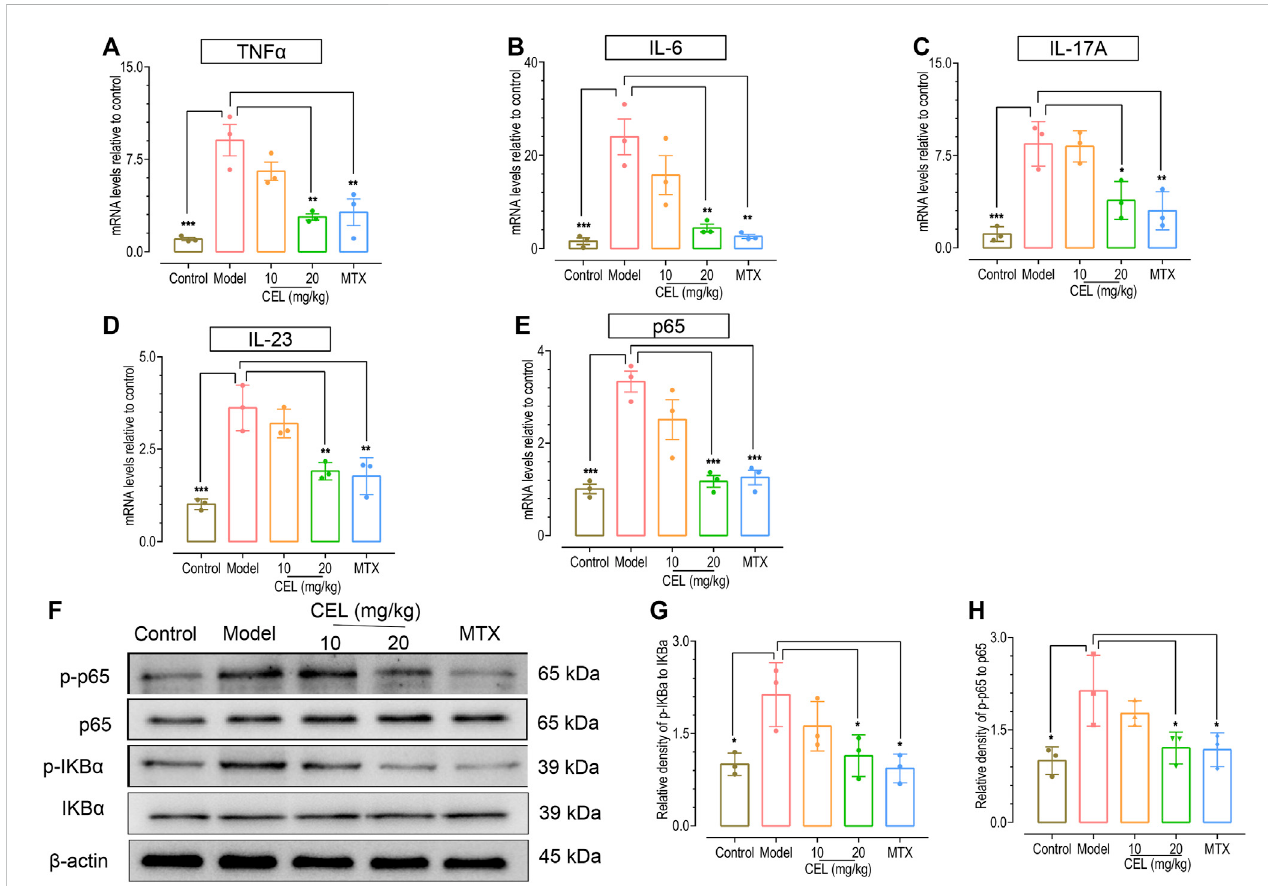
Celastrolattenuatedtheupregulationofproin fl ammatorycytokinesandNF κ Bsignalingintheskinofpsoriaticmouse.ThemRNAlevelsofTNF- α (A) ,IL-6 (B) , IL-17 A (C) , IL-23 (D) and p65 (E) in the skin of IMQ-induced psoriasis-like mice determined by RT PCR analysis. (F) Representative WESTERN blotting images of p-IKB α , IKB α , p-NF κ B p65 and NF κ B p65. (G,H) Quanti fi cation of the relative expression of p-IKB α /IKB α and p-NF κ B p65/NF κ B p65, β -actin expression was used to normalize data. Values were expressed as fold changes relative to control group that was set as 1.0. Data of column graphs are presented as the mean ± SD from three separate